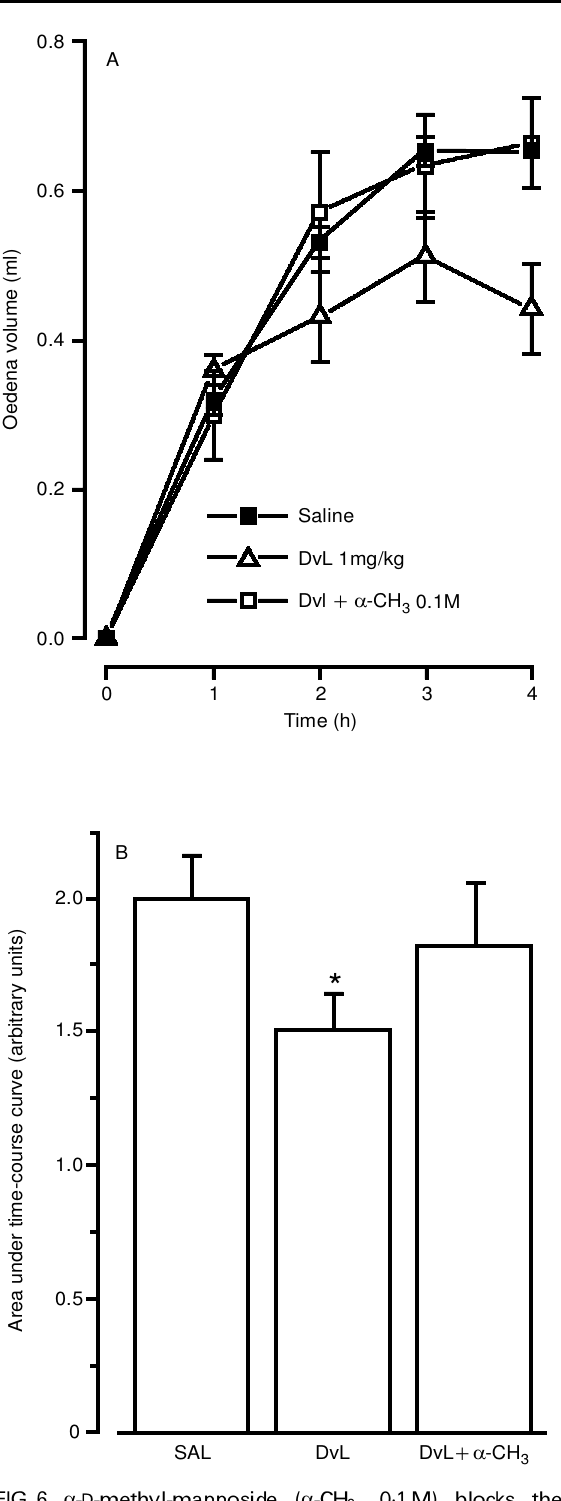
FIG. 6. a - D -methyl-mannoside ( a -CH 3 , 0 · 1 M) blocks the inhibitory effect of D. violacea (DvL) on the carrageenan (Cg)-induced rat paw oedema. The animals received saline, DvL or DvL + a -CH 3 30 min before Cg (300 m g / paw). (A) Oedema was measured at 1, 2, 3 and 4 h after the in¯ ammatory challenge and expressed as the increase in paw volume (ml) above its basal volume. (B) The area under the time-course curve was determined using a trapezoidal rule. Each point represents the mean SEM from 5 ± 10 rats. Indicates a signi® cant statistical difference ( P , 0.05), compared to the SAL group (ANOVA, Duncan’s